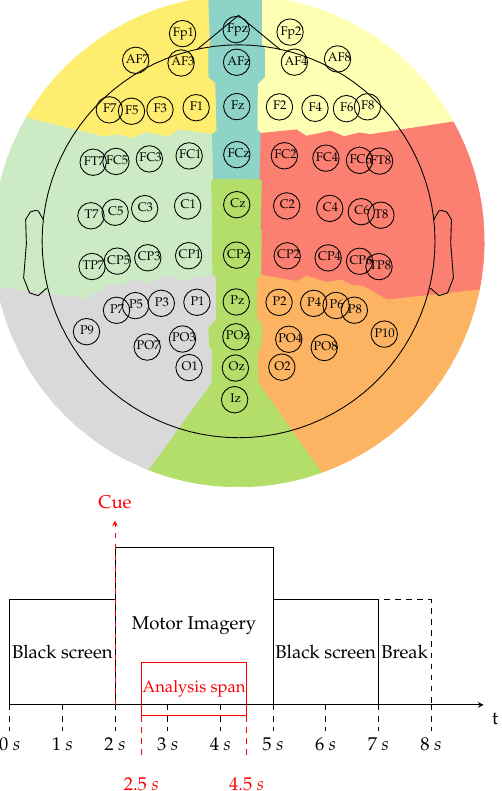
Figure 2. Giga dataset for Motor Imagery classification. First row: The dataset features a topoplot, which illustrates the sensor positions in a 10–10 placement electrode system, containing 64 channels. Besides, it highlights in color the main parts of the brain ( Frontal left, Frontal, Frontal right, Central right, Posterior right, Posterior, Posterior left, Central left). Second row: Motor Imagery paradigm. The EEG within the interval of 2.5 to 4.5 s is used for concrete testing in the classification of Motor Imagery for left vs. right